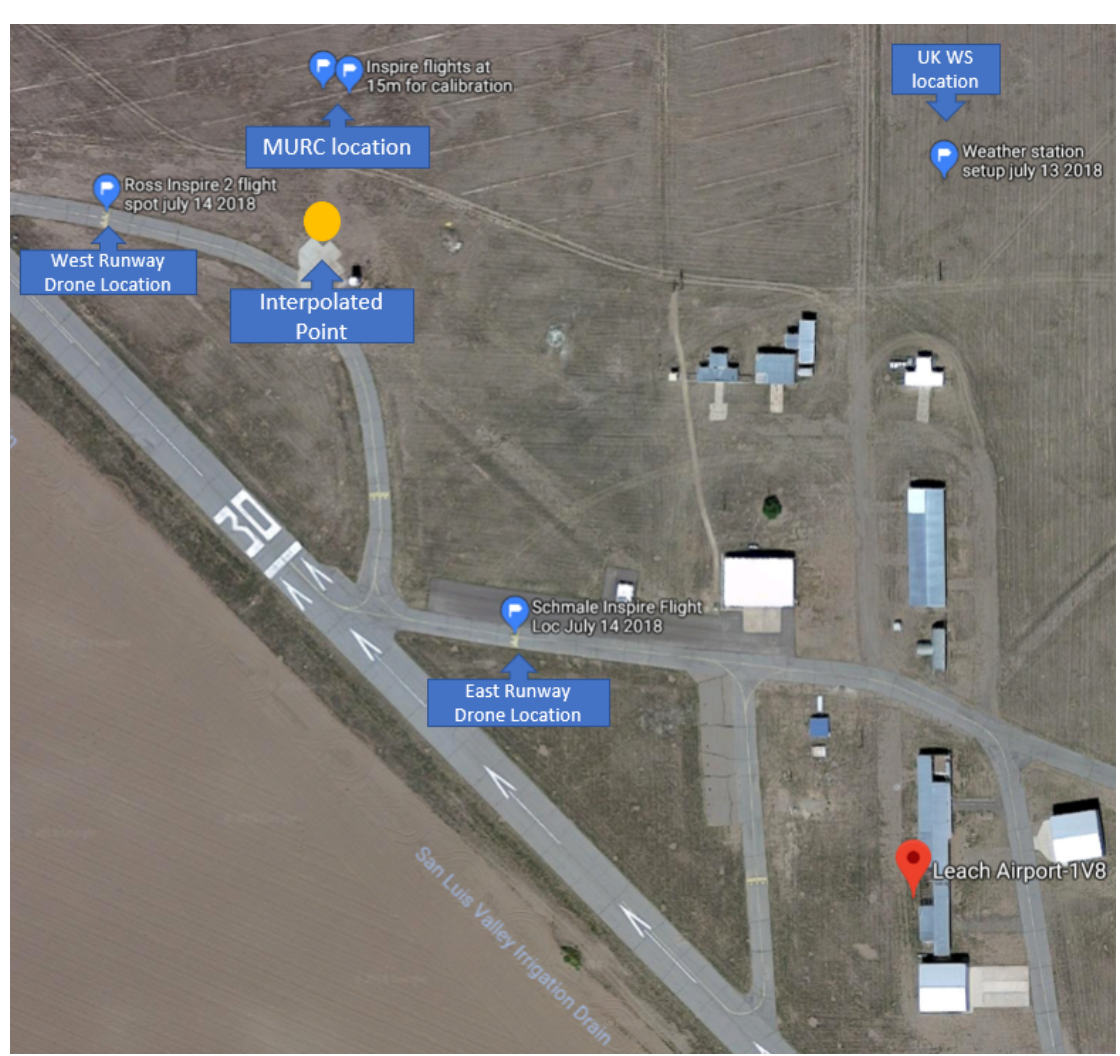
Figure 6. Satellite image of the sampling region with sensor locations marked with blue pins. A potential interpolated point is marked in